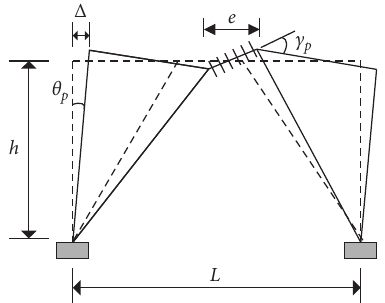
Figure 10: Free body diagram and deformation mechanism of